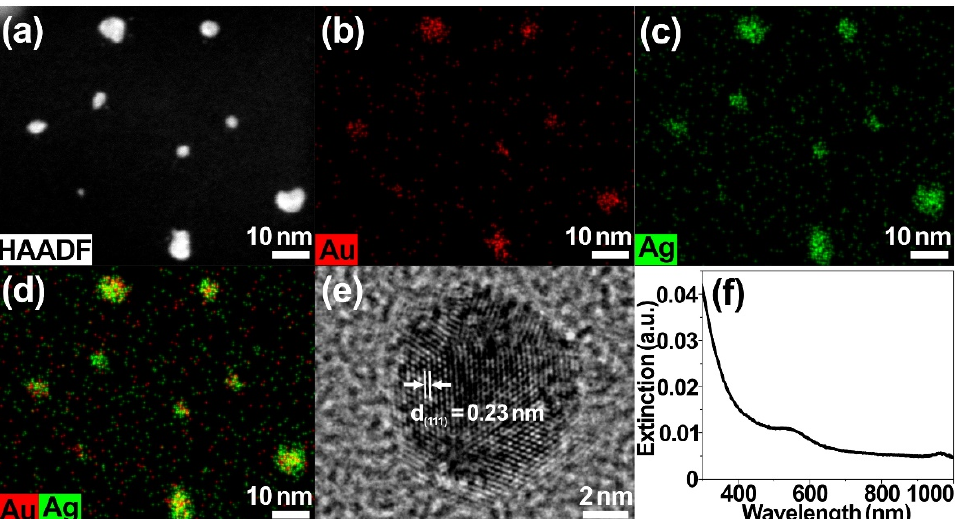
Figure 5. ( a ) High-angle annular dark-field (HAADF) scanning TEM image of the metallic bumps after removal of the AgCl NPs from the AgCl@AgAu NPs. Elemental distributions of ( b ) Au, ( c ) Ag, and ( d ) their overlaps are demonstrated. ( e ) High resolution TEM image of a single AgAu NP. The interplanar spacing is illustrated, which matches those of bulk Au and Ag in literature. ( f ) UV-vis spectrum of the AgAu NPs after removal of AgCl. The absorption band around 550–650 nm is a result of the uncontrolled aggregation of nanosized metallic Ag and Au and the consequent red-shift of their individual absorption bands.